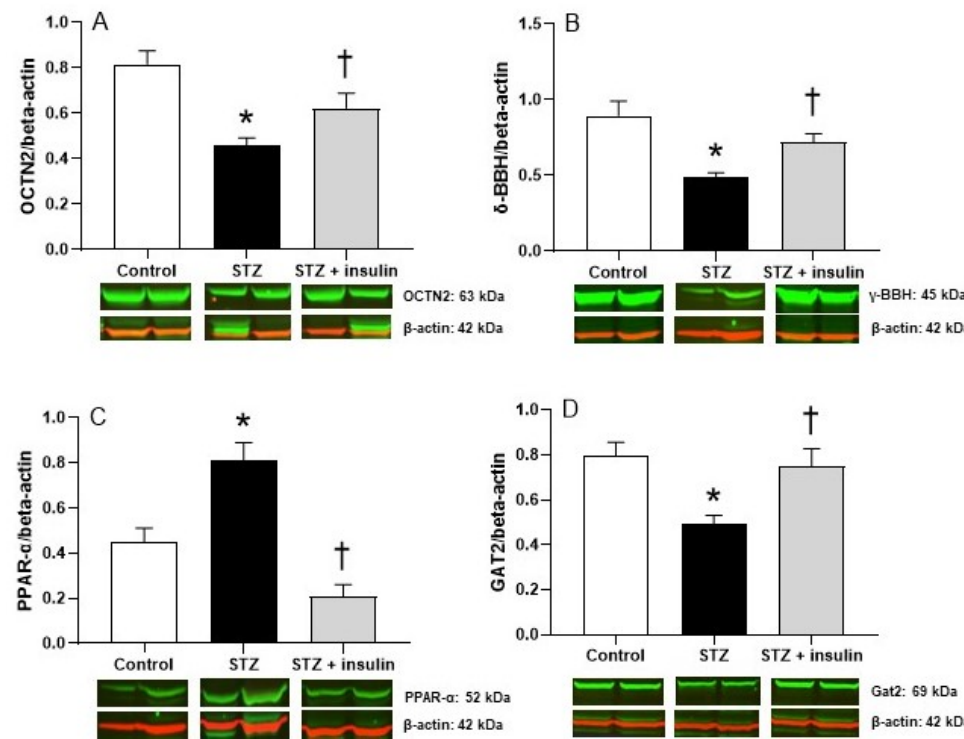
Figure 2. The effects of STZ-induced diabetes and insulin treatment on OCTN2 ( A ), γ -BBH ( B ), PPAR- α ( C ), and GAT2 ( D ) in rat kidney. STZ, streptozotocin; γ -BBH, gamma-butyrobetaine hydroxylase; OCTN2, novel organic anion transporter; PPAR- α , peroxisome proliferator-activated receptor-alpha; GAT2, gamma-aminobutyric acid transporter. Protein expression levels were normalized using β -actin as an internal control. Values are reported as mean ± SEM for 4–6 kidneys from two independent experiments. * p < 0.05 compared to control rats. † p < 0.05 compared to STZ rats.